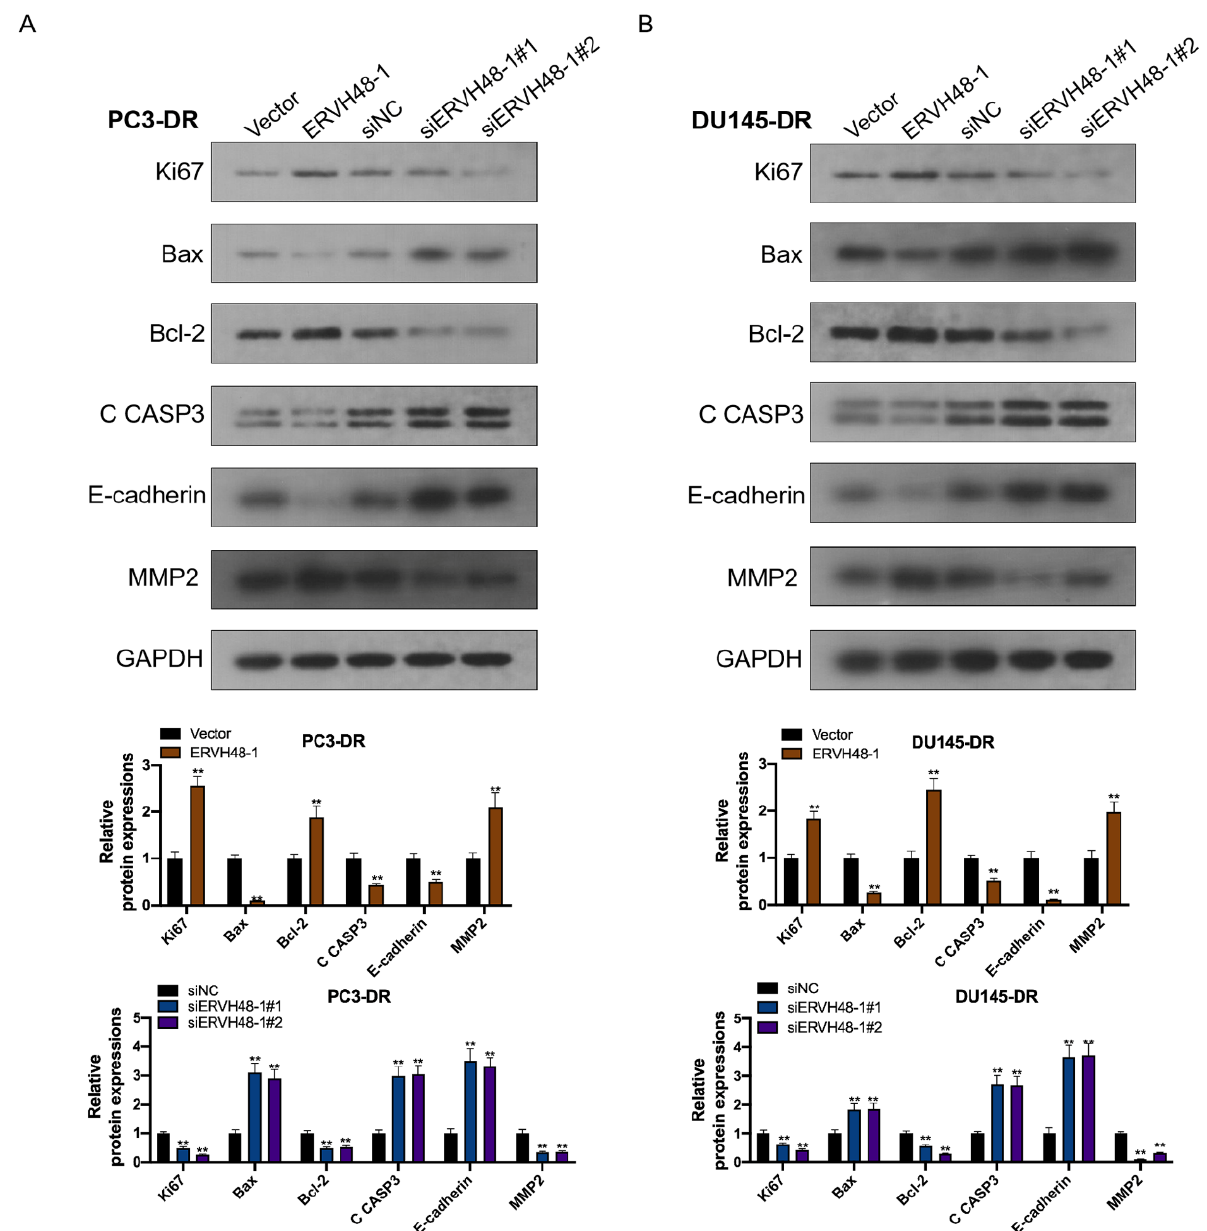
Figure 6. ERVH48-1 regulates related protein expression. In ERVH48-1-overexpressed PC3-DR and DU145-DR cells, Western blot assays were used to detect the expression of Ki67, Bax, Bcl-2, cleaved caspase-3, E-cadherin, and MMP2 ( A ). In ERVH48-1-inhibited PC3-DR and DU145-DR cells, Western blot assays weres used to detect the expression of Ki67, Bax, Bcl-2, cleaved caspase-3, E-cadherin, and MMP2 ( B ). ** p < 0.01. All experiments were repeated three times.